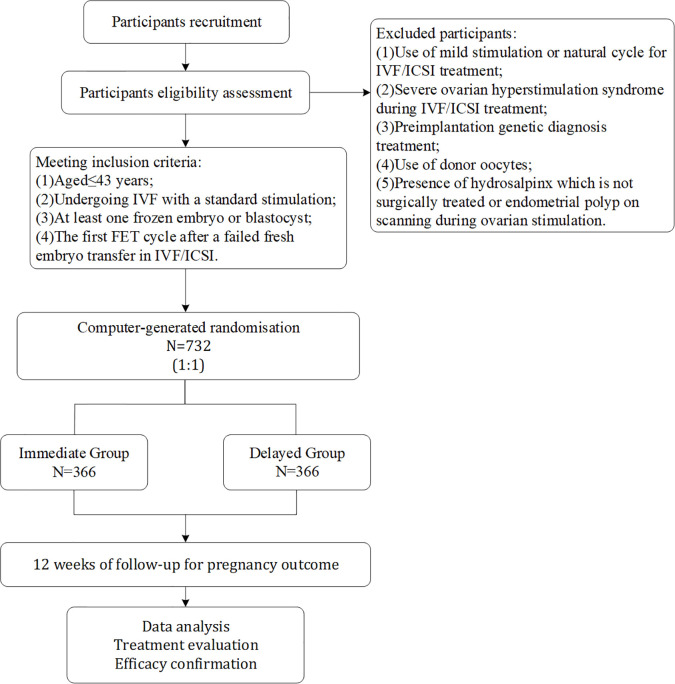
The study flowchart.